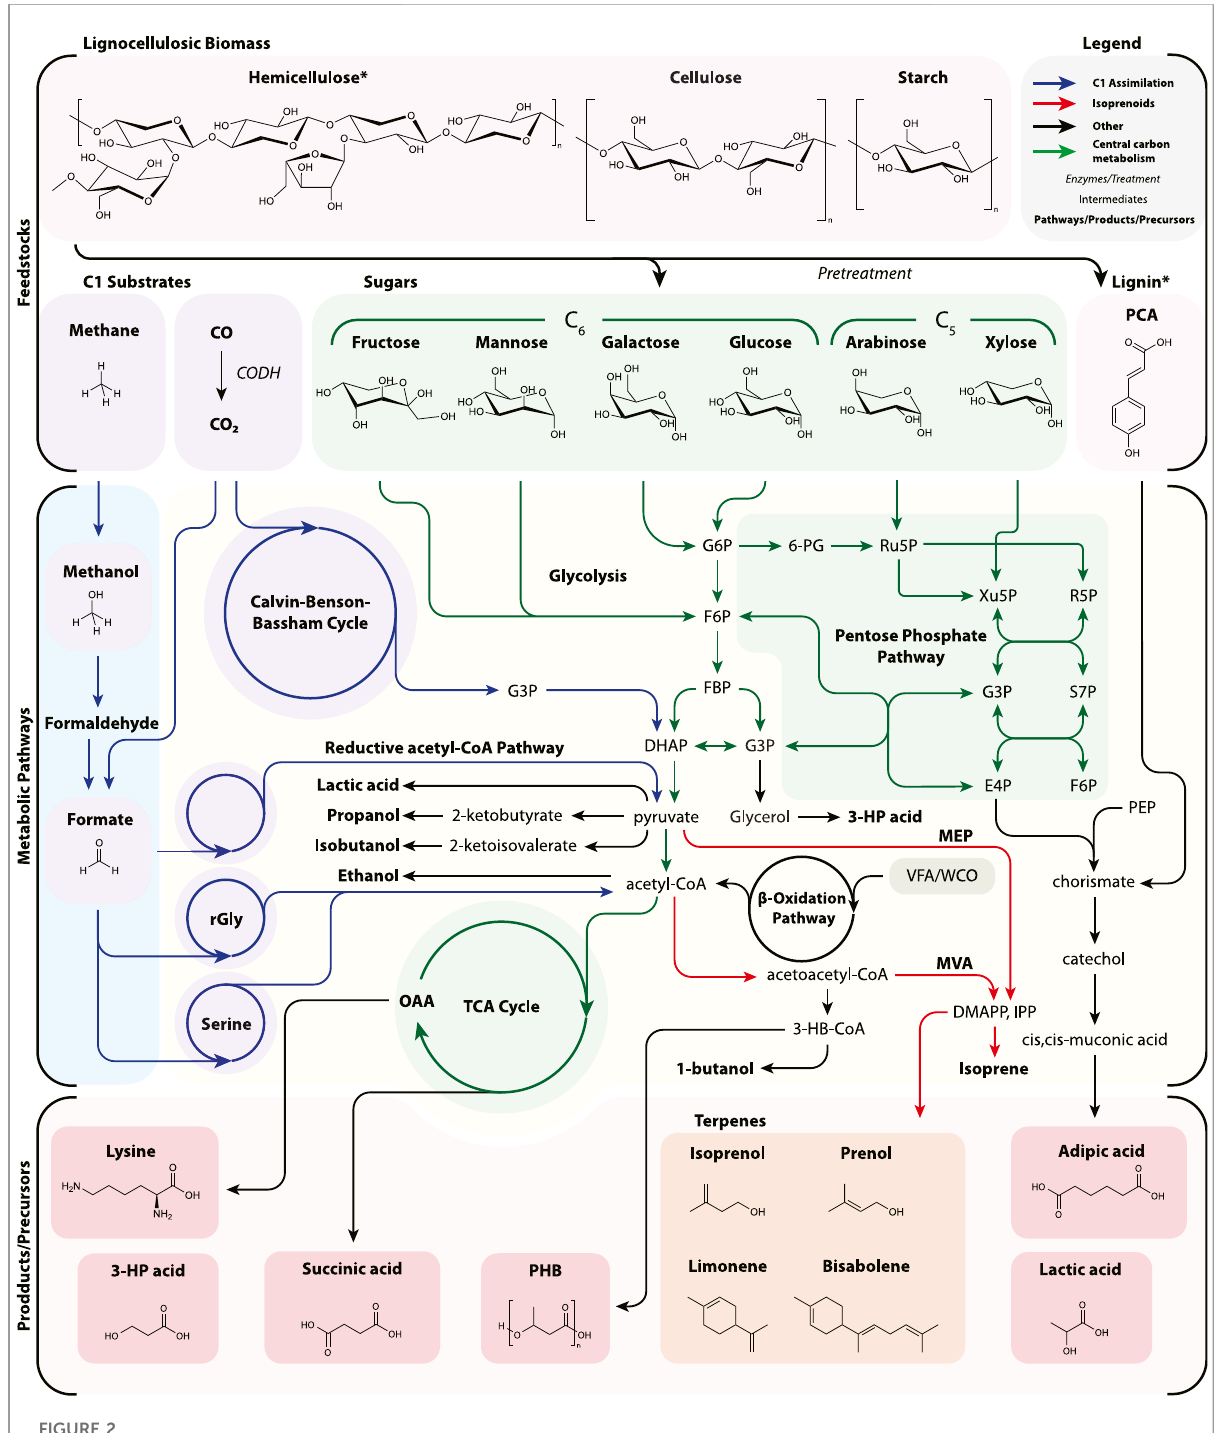
FIGURE 2 Asimpli fi eddiagramoffeedstockassimilationintobioproductionpathwayswithspeci fi cattentiontoC1(CO 2 ,CO,CH 4 ,methanol,andformate) as well as lignocellulosic biomass. Pathways are not exhaustive nor necessarily the most ef fi cient, but representative to the selection of bioproducts reviewed. Many other routes have been successfully demonstrated. For example, adipic acid production is depicted from p -coumaric acid via the shikimate pathway and from lignin derivatives, though may be generated from glucaric acid, TCA intermediates, and the β -oxidation pathway. Lignin is represented by a single aromatic, p -coumaric acid, and cis , cis -muconic acid is usually chemically hydrogenated to adipic acid. Likewise, certain pathways have been simpli fi ed for clarity (e.g., lysine and CO assimilation). 3-HP acid, 3-hydroxypropionic acid; 6PG, 6-phosphogluconate; CoA, coenzyme A; CODH, carbon monoxide dehydrogenase; DHAP, dihydroxyacetone phosphate; DMAPP, dimethylallyl diphosphate; E4P, erythrose-4-phosphate; F6P, fructose 6-phosphate; FBP, fructose 1,6-bisphosphatase; G3P, glyceraldehyde-3-phosphate; G6P, glucose-6-